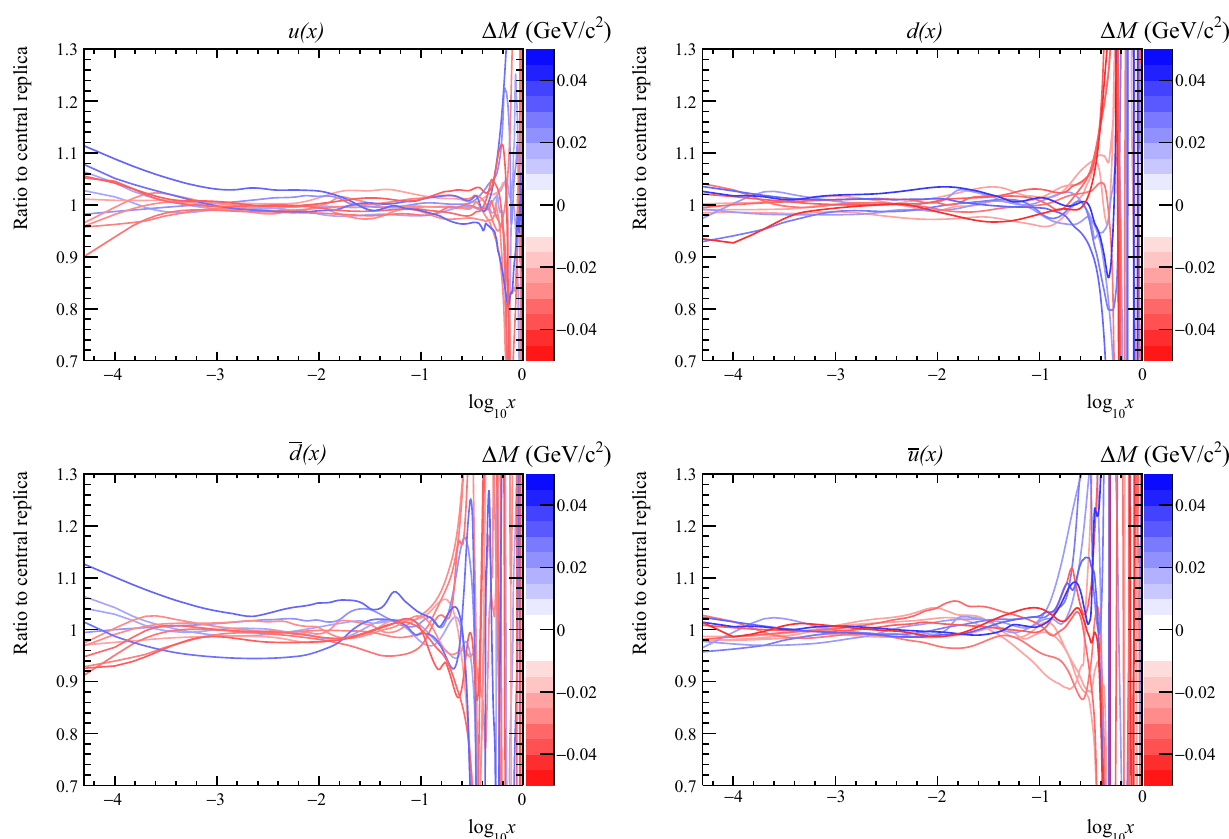
μ distribution of a T